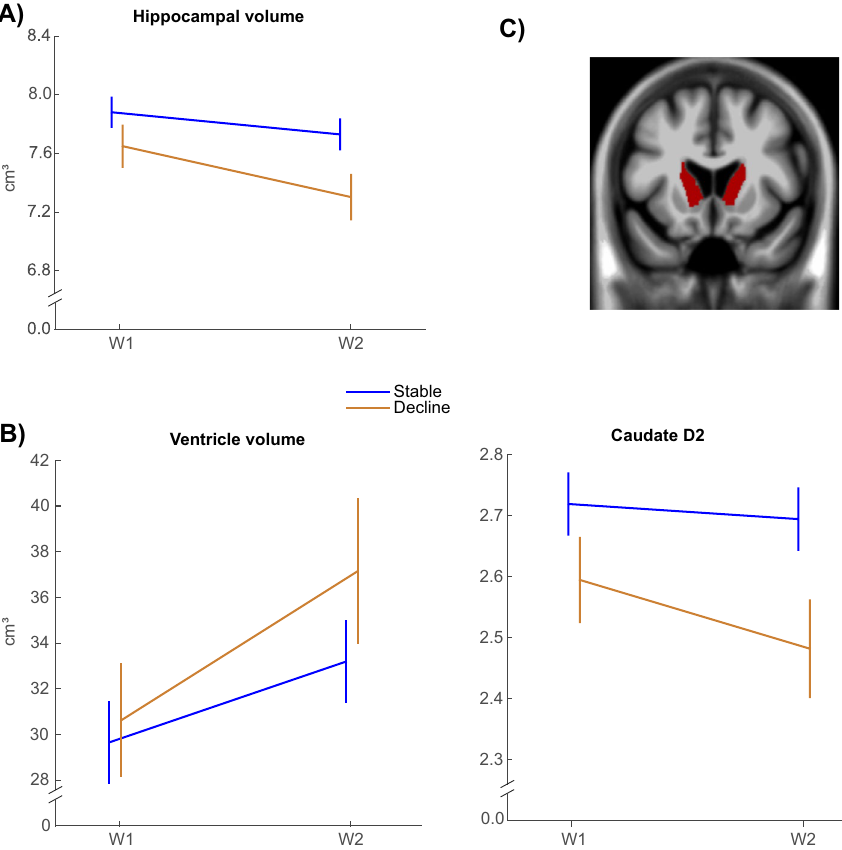
Figure 3. Comparison of stable and declining WM groups on markers of neuronal integrity and neurotransmission. ( A ) Hippocampal volume, ( B ) Ventricle volume, and ( C ) Caudate dopamine D2 binding potential. (Mean ± 1SE). W =